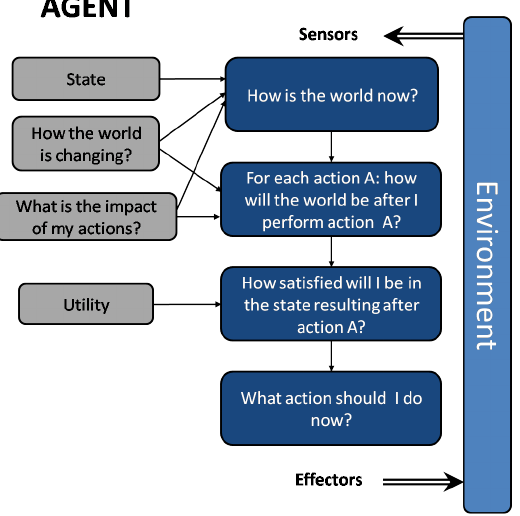
Figure 5. Agent utility-based architecture proposed by Russel